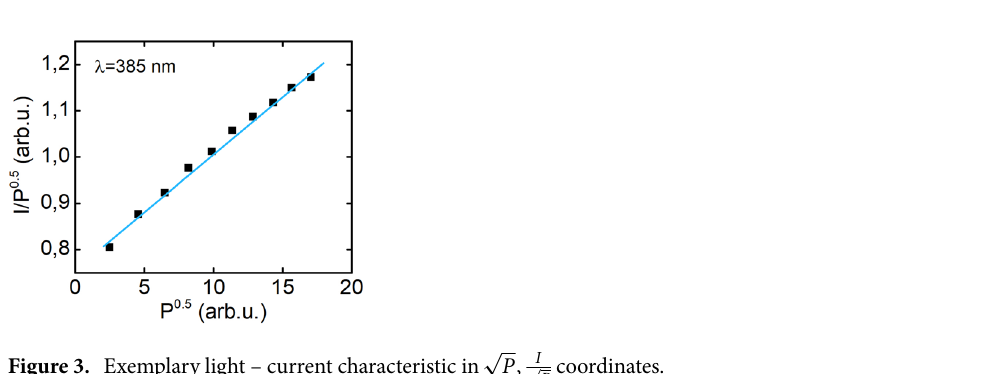
Figure 3. Exemplary light – current characteristic in √ P ,